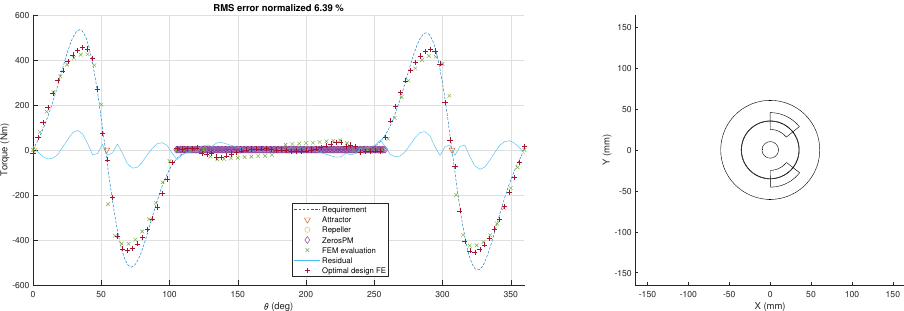
Figure 7. Extended parametrization approach, optimization results for cam-follower reference torque. Left —FEM torque characteristic calculation, right —initial magnetic spring